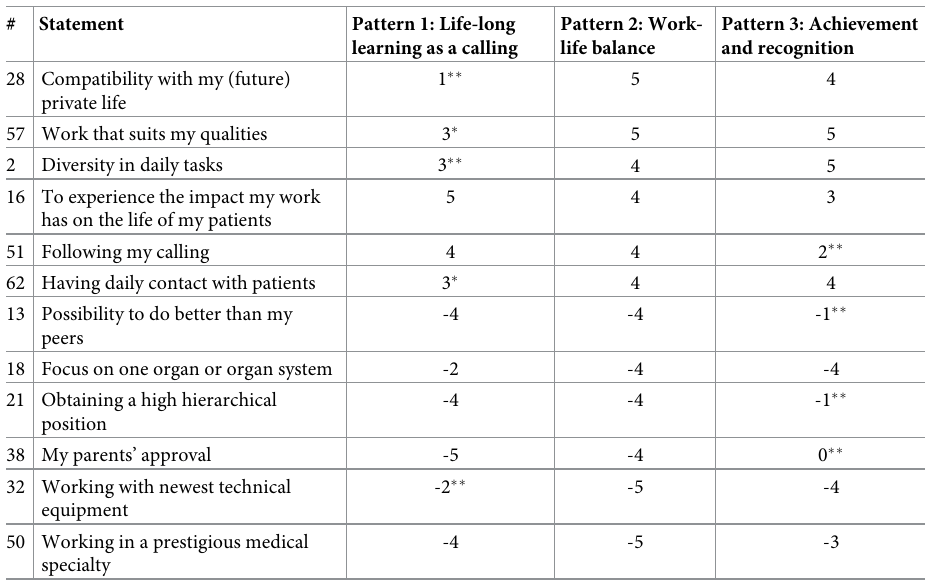
Table 4. Characterising statements pattern